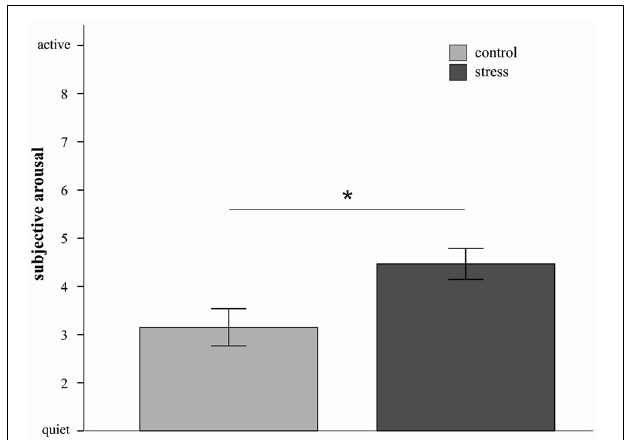
FIGURE 3 | Mean emotional ratings ( ± s.e.m.) to sample pictures in the decrease condition are depicted for both sexes in the stress and control group. Stressed women in the decrease condition reported higher subjective valence than control women ∗ p = 0 . 05 ( t -test).